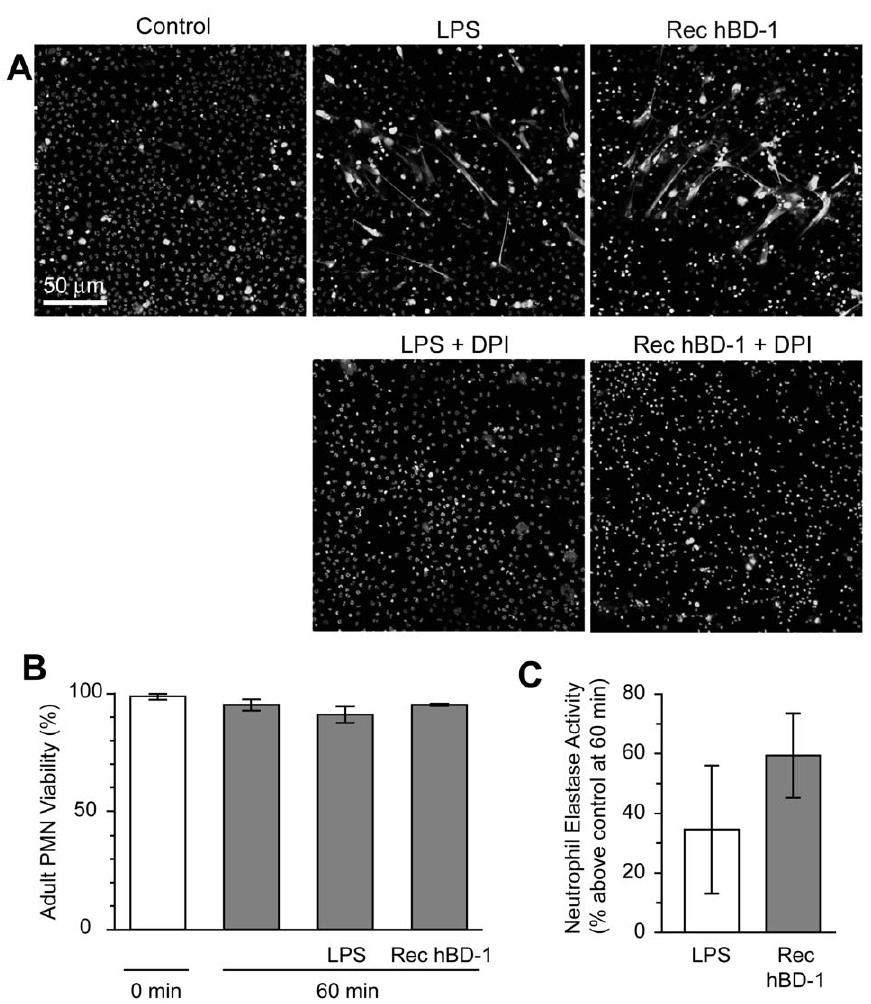
Figure 7. b -defensin 1 mediated NET formation is dependent on reactive oxygen species. (A) PMNs were incubated with diphenylene iodonium (DPI) and then left untreated (control) or stimulated with 100 ngl/ml of LPS or hBD-1 for 1 hour. Images are representative of three independent experiments. (B) PMNs were left alone or treated with 100 ng/ml of LPS or recombinant hBD-1 for 1 hour and then stained with trypan blue to determine cell viability. (C) PMNs were left alone or incubated with 100 ng/ml of LPS or recombinant hBD-1. After 1 hour, neutrophil elastase activity was measured. The bar graph represents the percent increase in neutrophil elastase activity over untreated neutrophils. The bars in panel B and C represent the mean 6 SEM of three independent